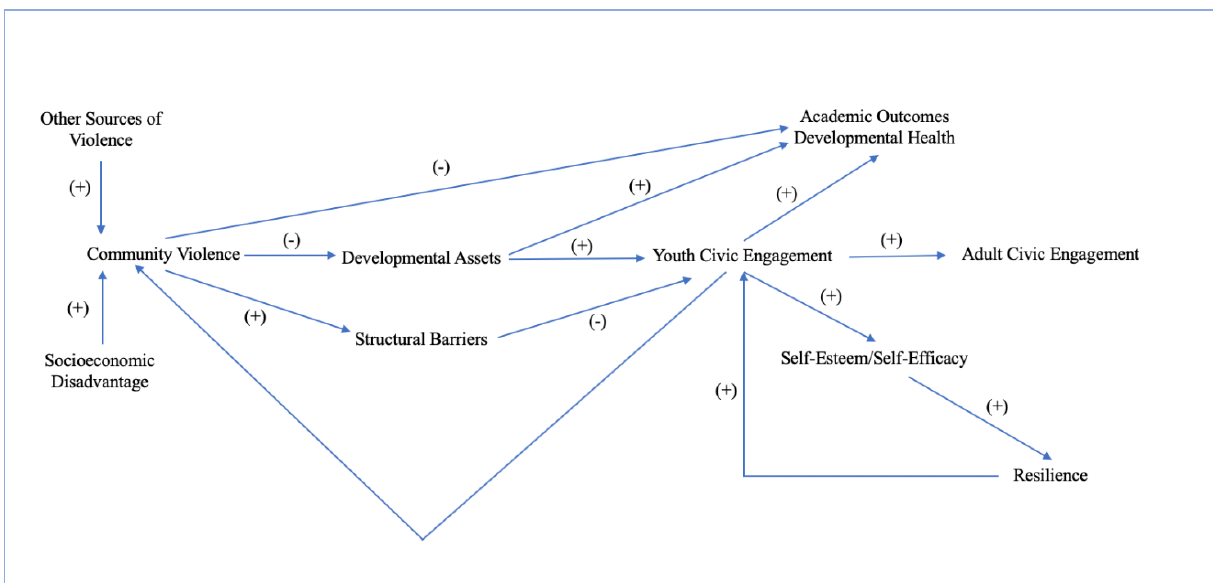
Figure 1. Pathways Through Which Exposure to Community Violence May Impact Youth Civic